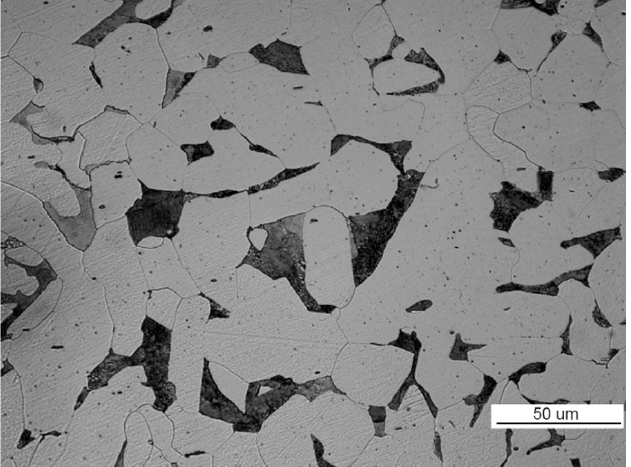
Figure 45. The structure of the steel in part 1 (handy-size bulk carrier 30185 DWT). Optical